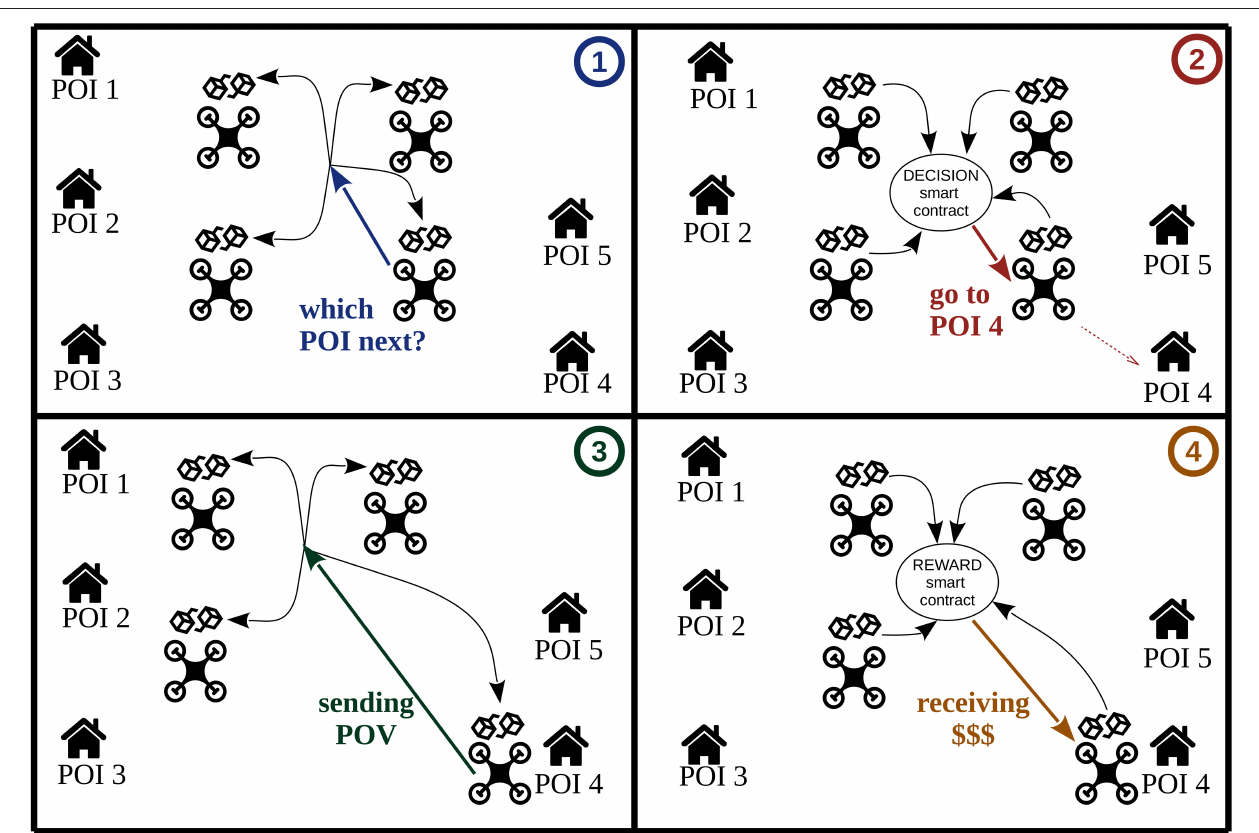
FIGURE 4 | A schema of surveillance service marketplace where the UAVs are the service providers and the POIs are the service seekers. It illustrates the visit of a POI by a UAV in four steps. In step (cid:192) , a free UAV asks to the blockchain (i.e., to all nodes in the blockchain network) which POI it must visit. The corresponding smart contract, executed by all the nodes of the blockchain, launches the decision algorithm described in section 3.3 and returns to the UAV of the chosen POI in step ` . Then, step ´ shows the POI visited by the UAV and produced a proof-of-visit (POV), which is stored in the blockchain. Finally, in step ˆ , the smart contract managing the rewards validates the POV and pays the corresponding reward to the